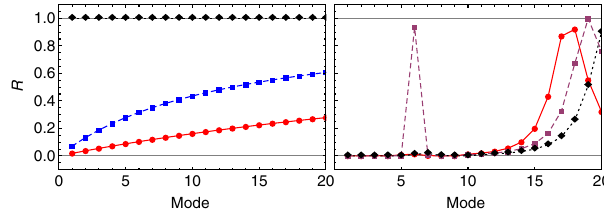
n; − γ ij 2 = ðjh n; γ j ˆ s n; γ ij 2 þ z j z j